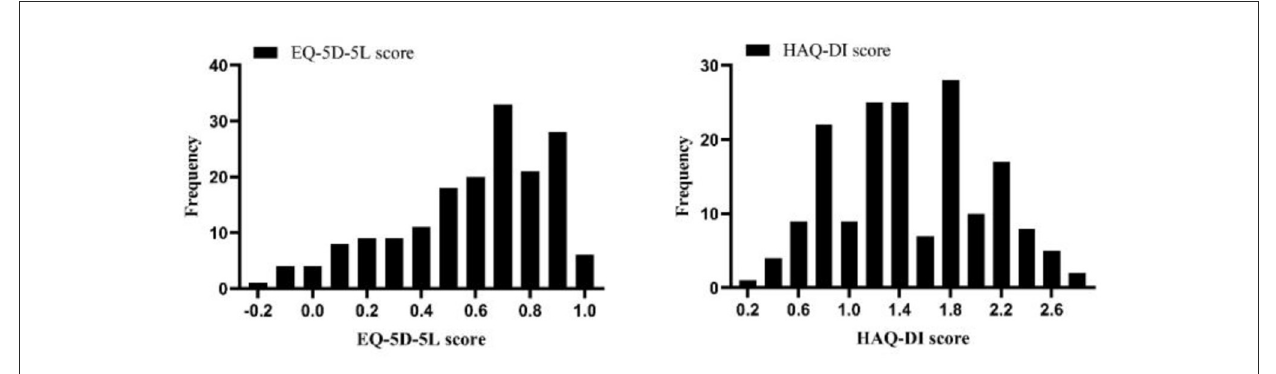
FIGURE1 Distributions of EQ-5D-5L utility scores and HAQ-DI scores.